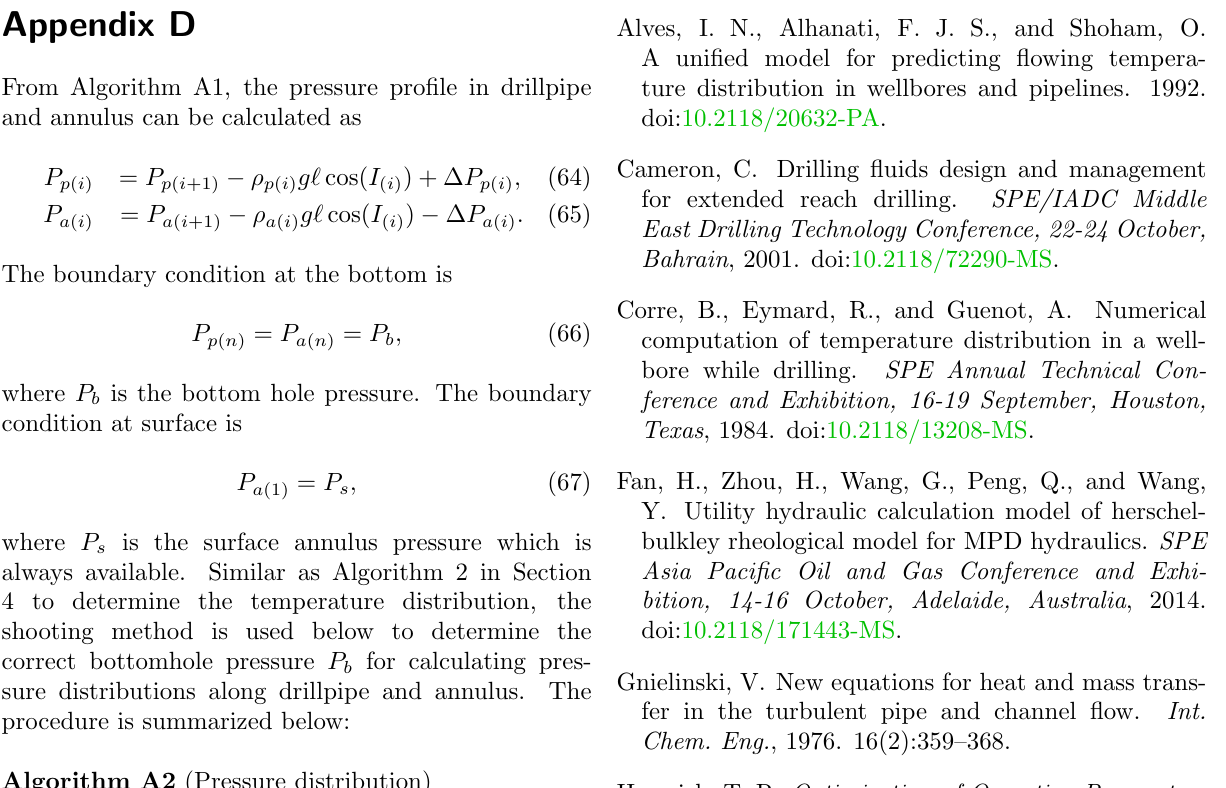
Algorithm A2 (Pressure